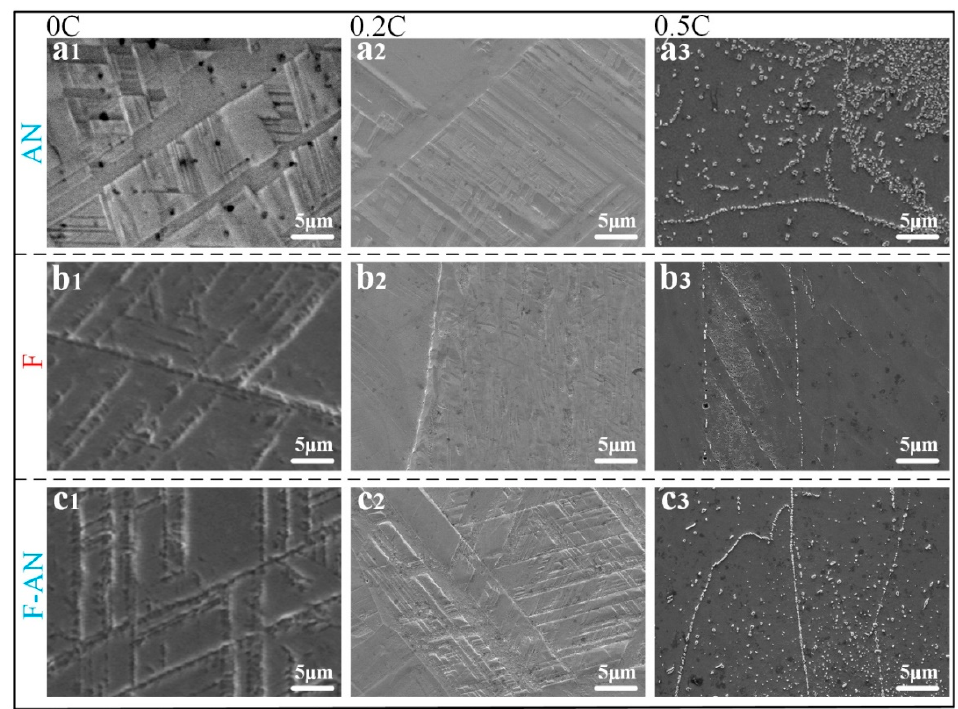
Figure 6. SEM images of the specimens with different carbon contents under different heat treatment states. ( a ) the annealed as-cast specimen (AN); ( b ) the forged as-cast specimen (F); ( c ) the forged-annealed as-cast specimen (F-AN).